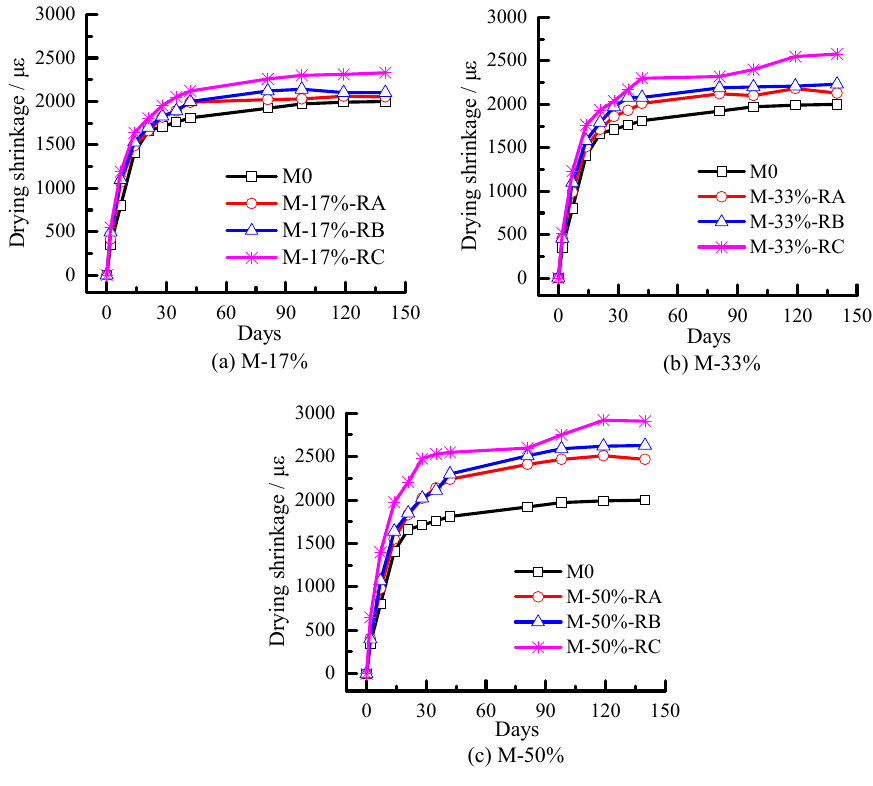
Figure 8. Drying shrinkage of mortars.